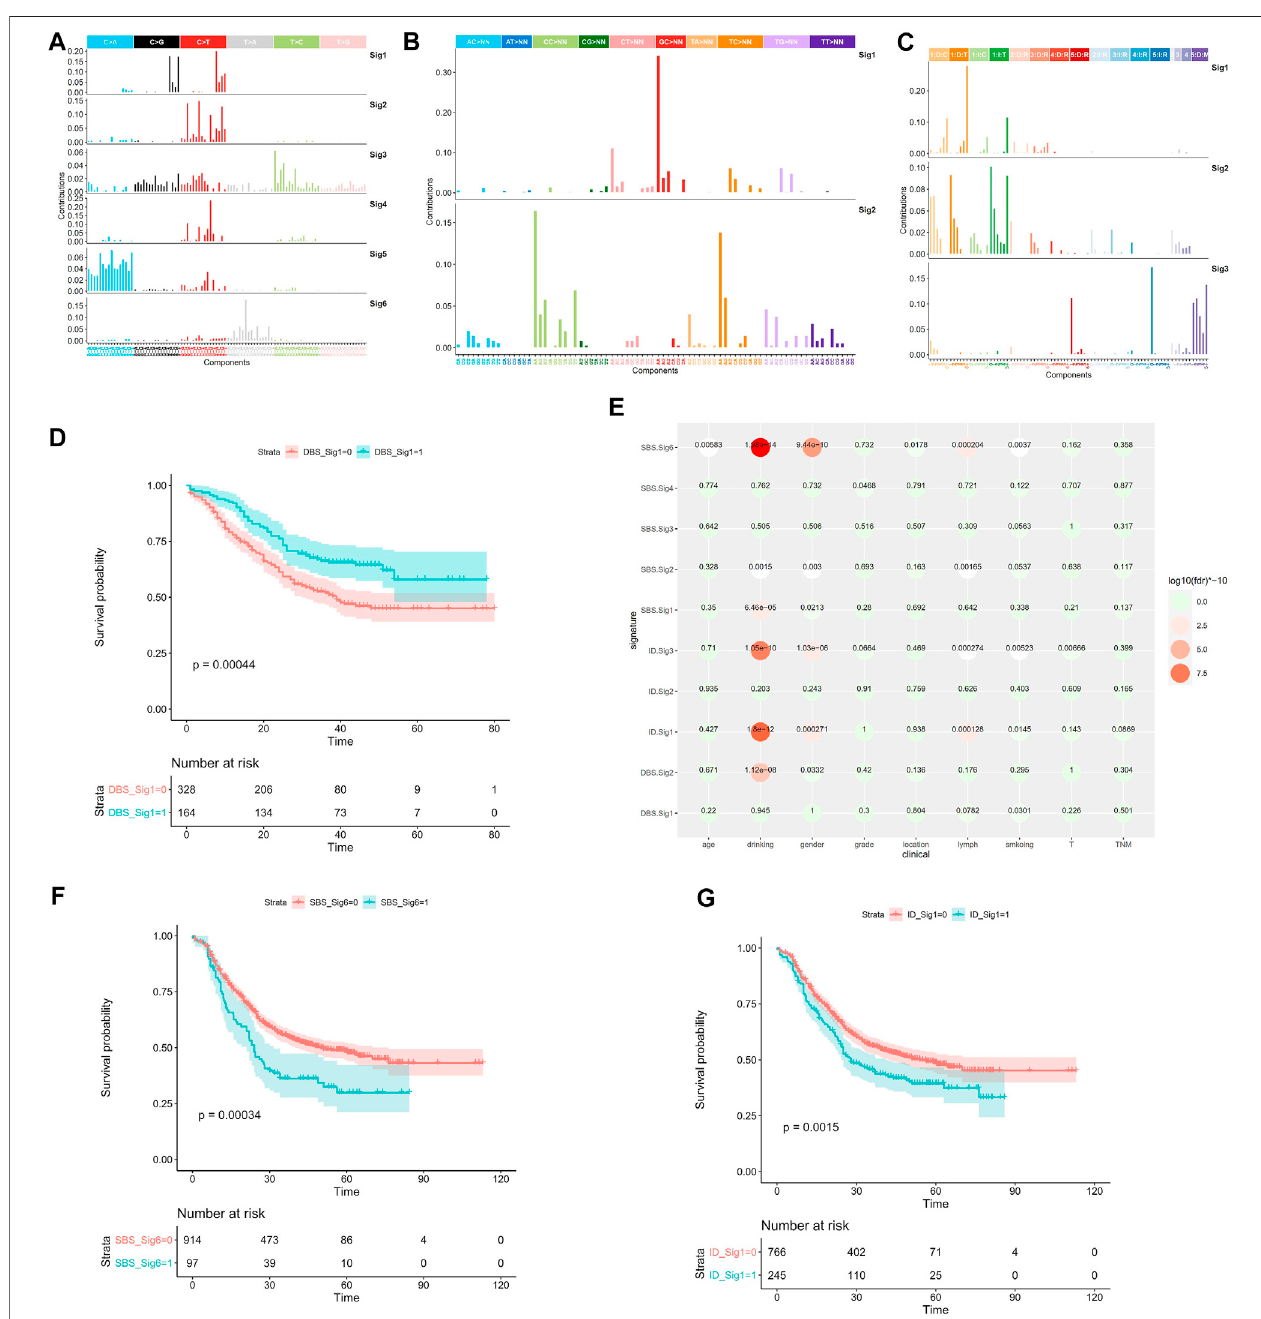
FIGURE 2 | Mutation signature of coding region in ESCC. (A) SBS signatures of WES, (B) DBS signatures of WES, (C) ID signatures of WES, (D) WGS-DBS-S1 survival analysis, (E) WES signature correlation with clinical characteristics, (F) WES-SBS-S6 survival analysis, (G) WES-ID-S1 survival analysis. In the survival analysis, red line represents the ESCC patients enrichment in the signature, the green line represents ESCC patients without enrichment in the signature.